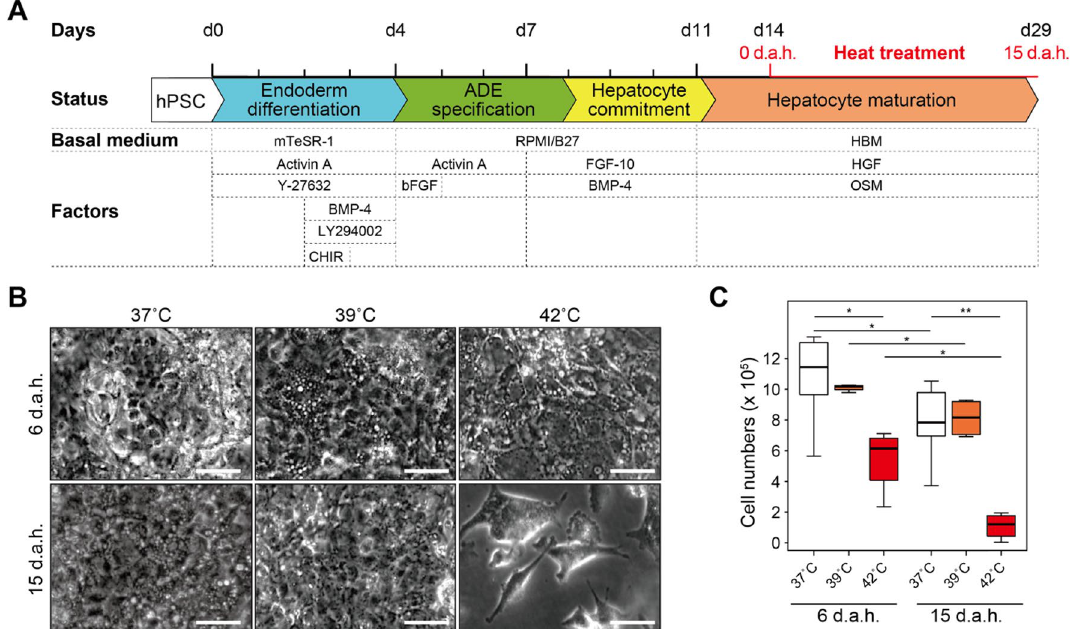
Figure 1. Functionalization of hepatocyte-like cells derived from hESCs by heat treatment. ( A ) Schematic representation of the protocol to functionalize hESC-HLCs. d.a.h. represents days after heat treatment. Initially, hPSCs were treated with mTeSR-1 medium supplemented with combinations of Activin A, BMP-4, CHIR99021 (CHIR), LY294002, and Y-27632 to induce definitive endoderm (DE) differentiation until Day 4 (d4). Then, cells were treated with Activin A in RPMI medium supplemented with B27 for anterior definitive endoderm (ADE) specification until Day 8. As the next step, cells were treated with BMP-4 and FGF-10 for inducing hepatocyte commitment in RPMI medium supplemented with B27 until Day 11. Finally, cells were treated with oncostatin M (OSM) and hepatocyte growth factor (HGF) in basal hepatocyte medium for hepatocyte maturation. On day 14, cells were incubated at 37, 39, or 42 °C, and half the total amount of the medium was changed every day. ( B ) Microscopic images of hESC-HLCs treated with 37, 39, and 42 °C at 6 and 15 d.a.h. Scale bars represent 50 µm. ( C ) Box plots showing the cell numbers of living hESC-HLCs after heat treatments at 37, 39, and 42 °C at 6 and 15 d.a.h. (n = 4). Centerlines of box plots indicate medians; box limits indicate the 25th and 75th percentiles as determined by R software; whiskers extend 1.5 times the interquartile range from the 25th and 75th percentiles; * p < 0.05, ** p <